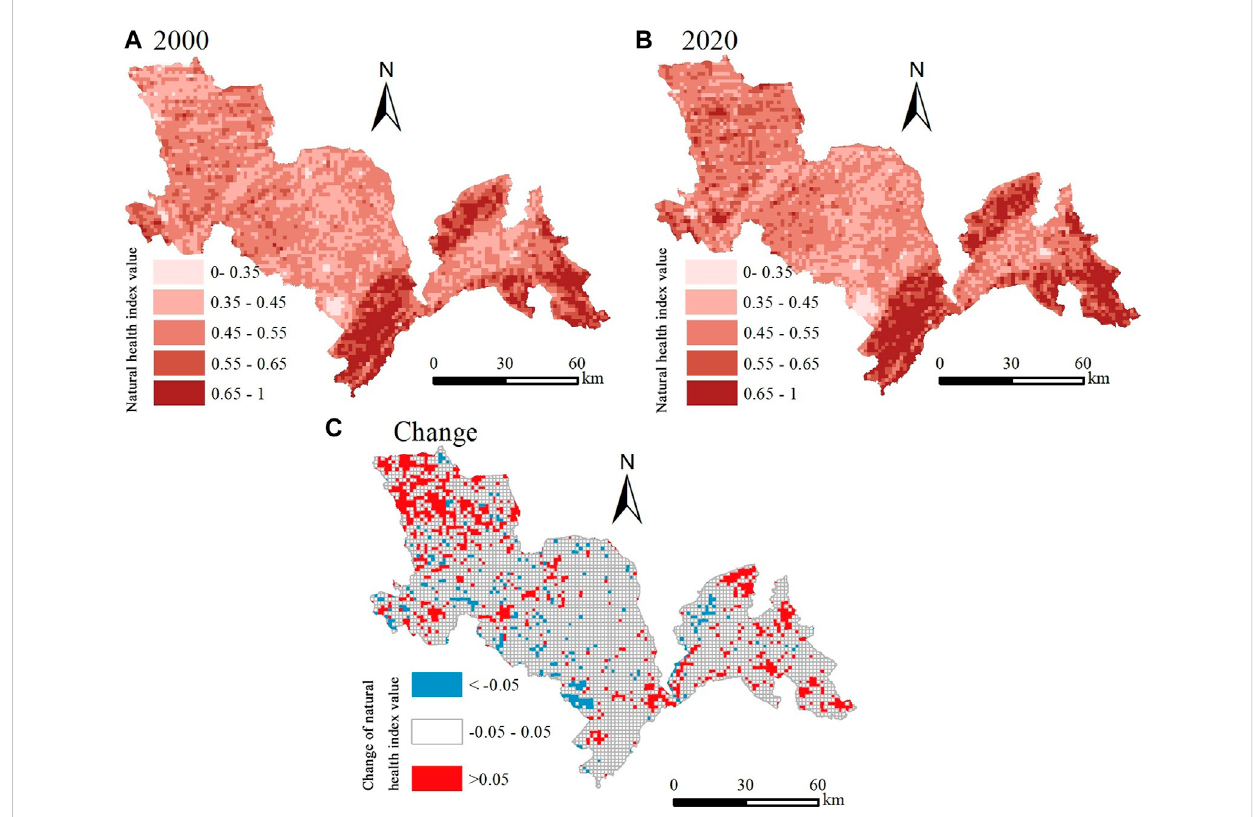
FIGURE 4 Natural index of ecosystem health in (A) 2000 and (B) 2020, and (C) its temporal